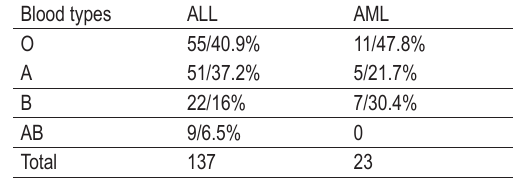
TABLE 5. Distribution of blood types